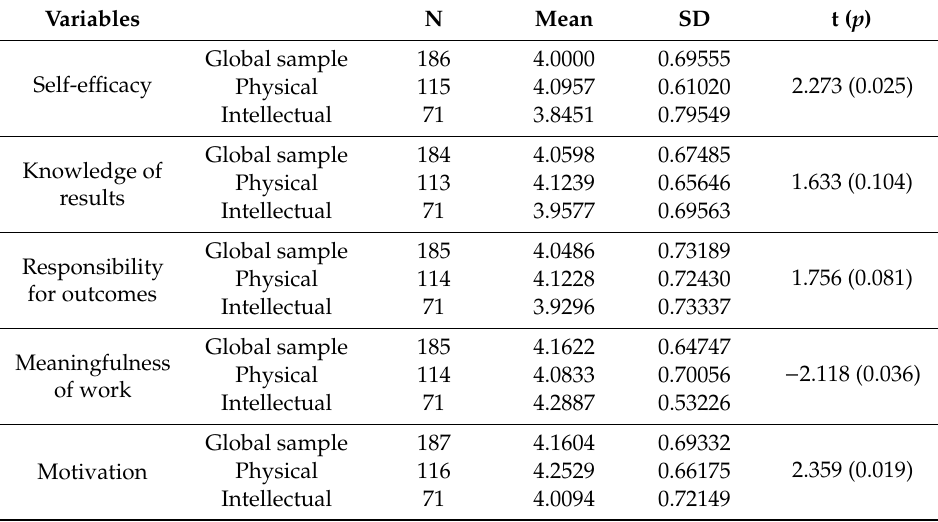
Table 2. Mean comparisons between